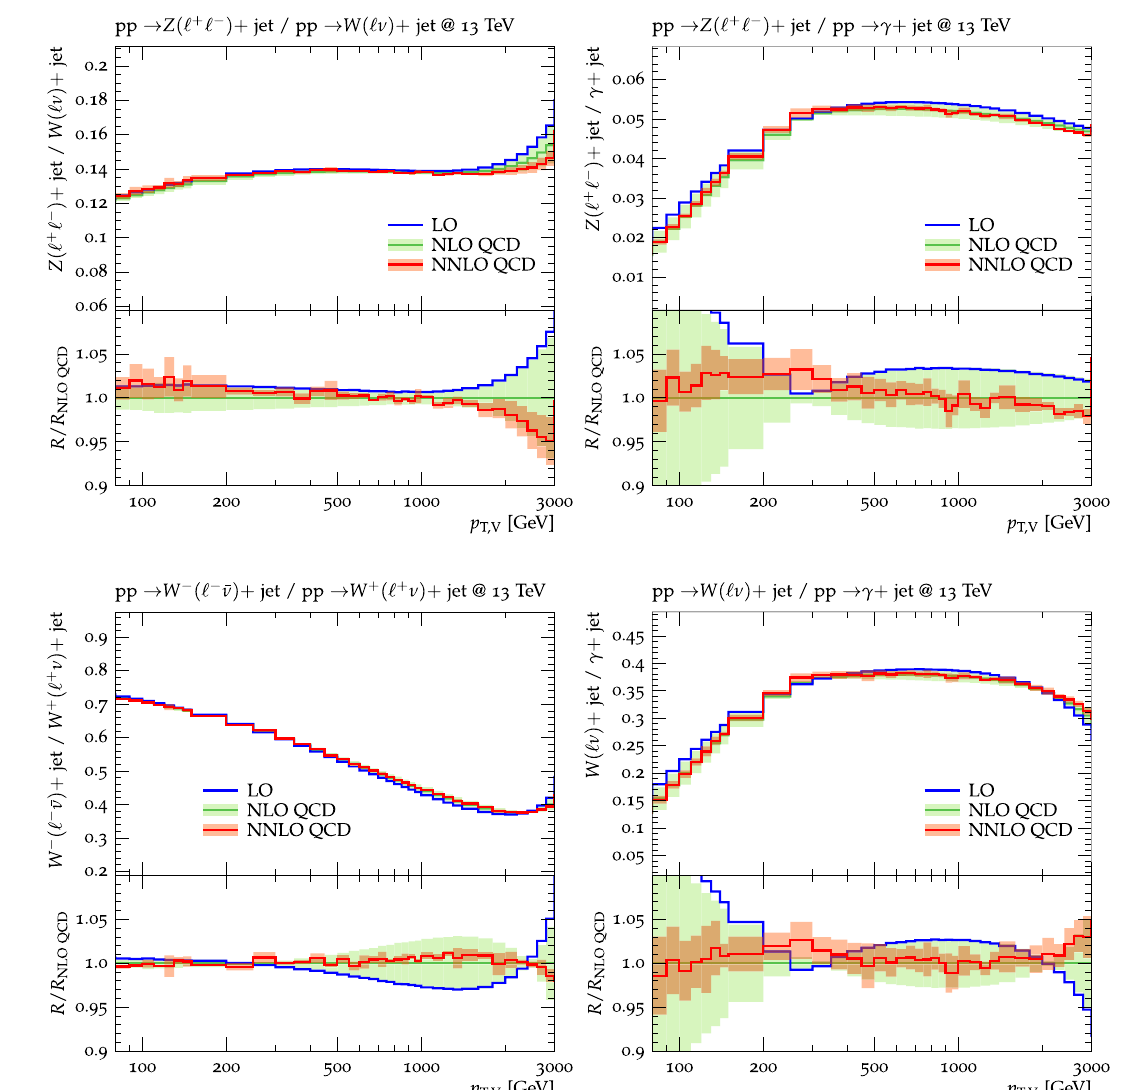
processes as described in the text and combined in quadrature. At LO only nominal predictions are